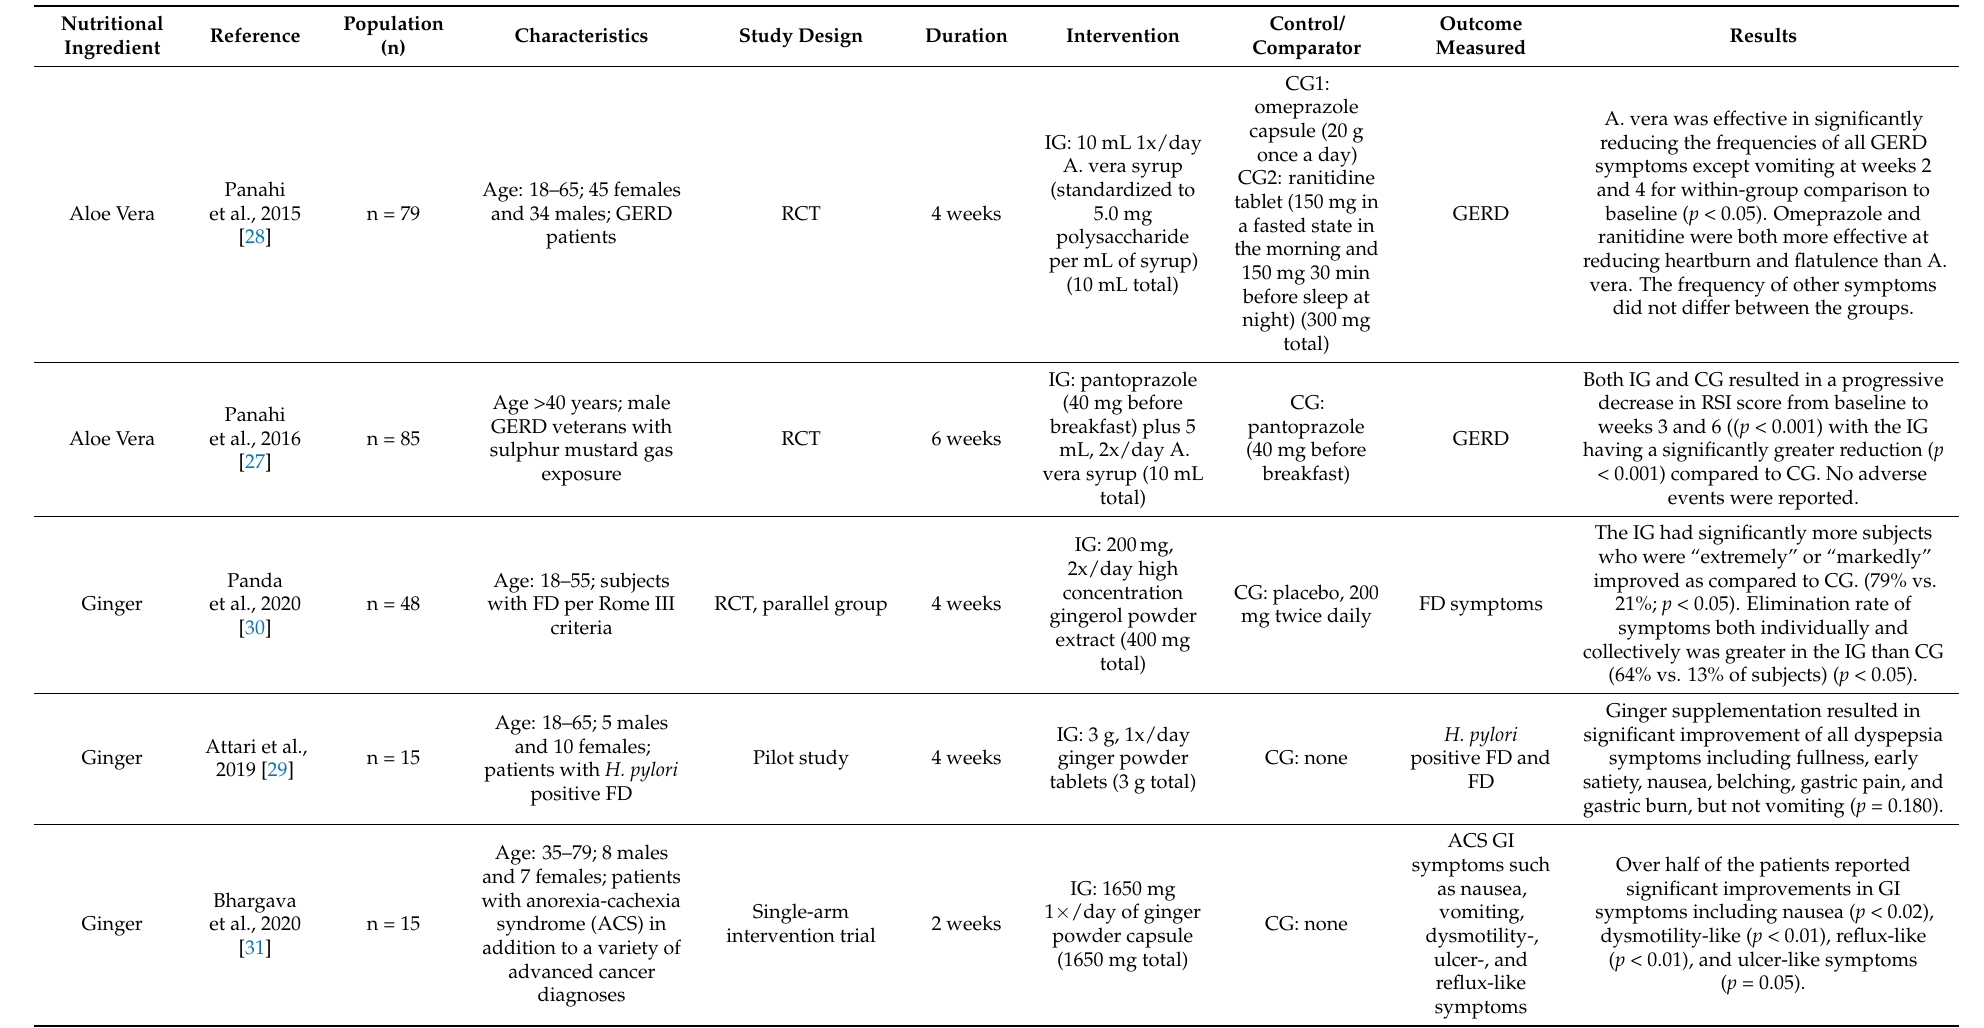
Table 5. Summary of human trials on “other” botanical ingredients and upper GI